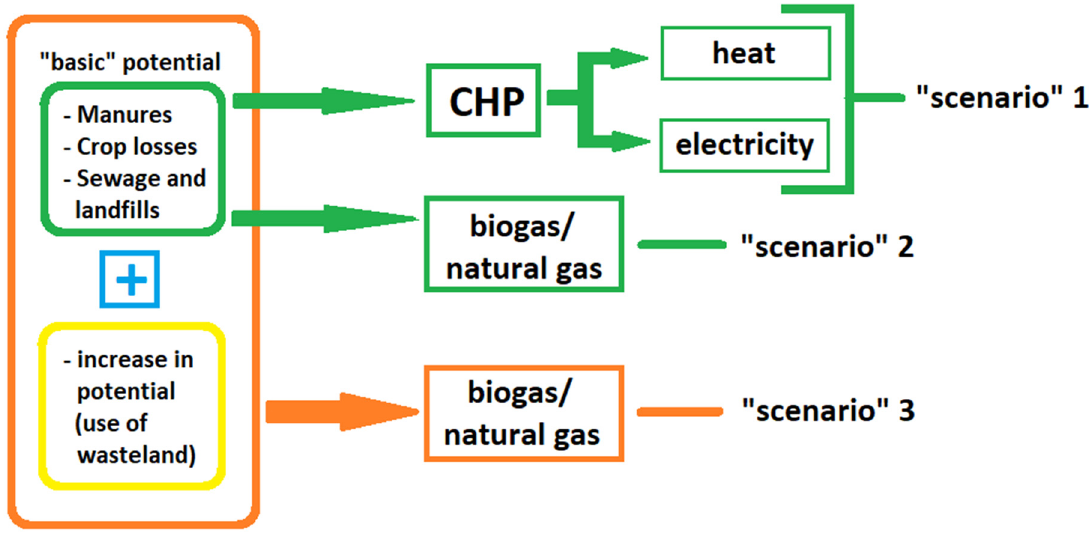
Figure 1. Diagram of the methodology used in the work. Source: Own study.